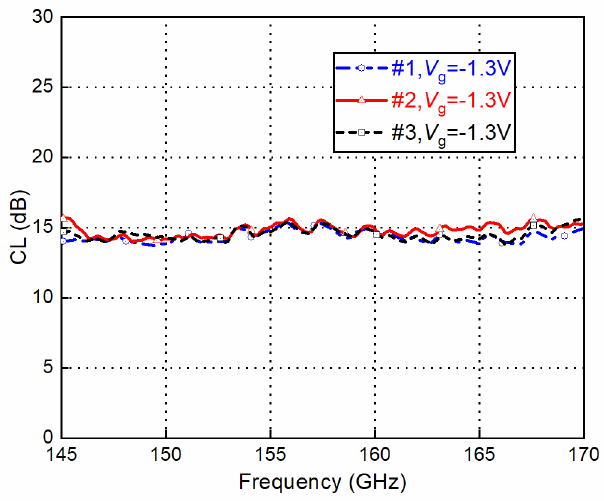
Figure 19. Conversion loss (CL) vs. frequency. Comparison between the three modules.